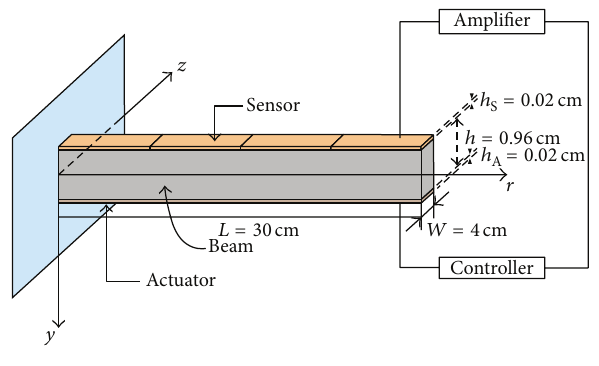
Figure 1: Smart beam.